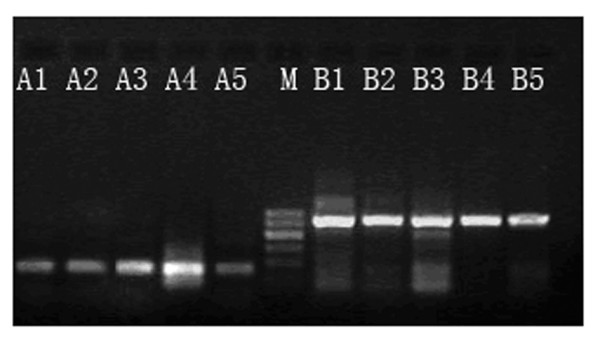
Expression of IGFBP-5 (154 bp, A-lanes) and β-actin (540 bp, B-lanes) mRNA. M = Marker, A1 = Normal cervical tissues group, A2-5 respectively express CIN I, II, III, and cervical squamous cell carcinoma groups.